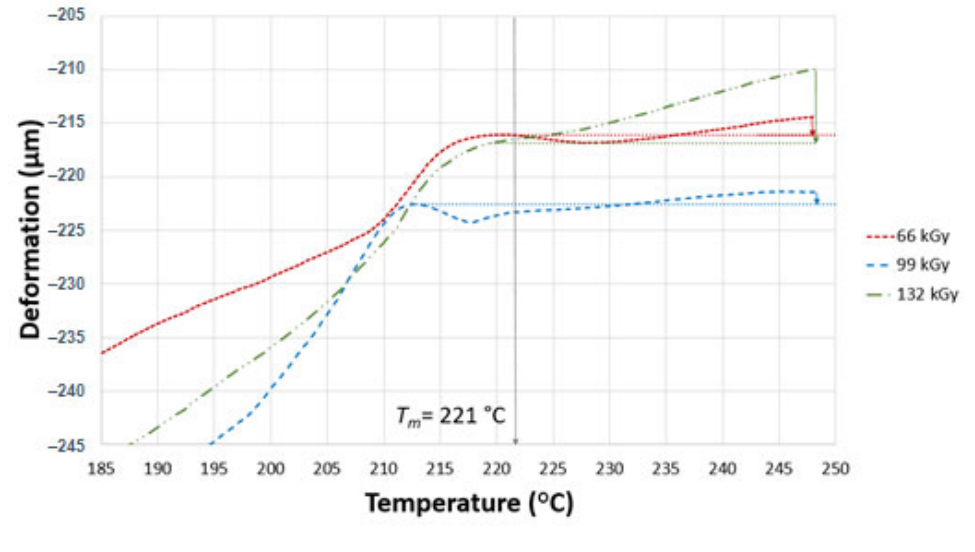
Figure 9. TMA of sample C.